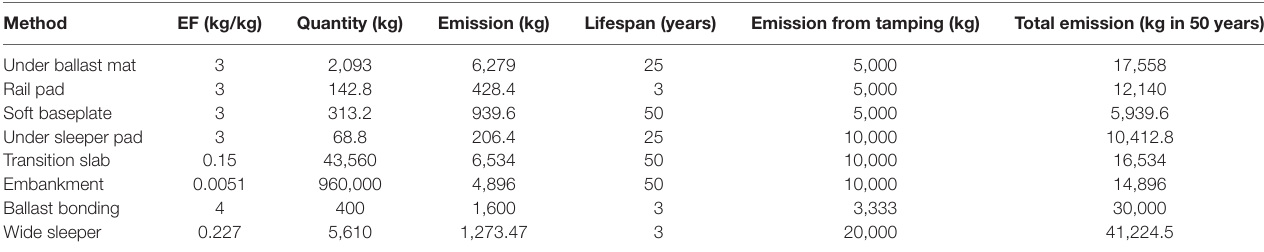
TaBle 6 | Carbon emission from bridge approach material in control case.